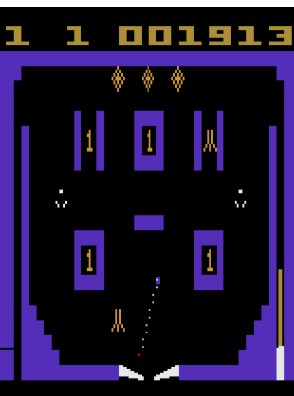
Figure 4. ATARI pinball game high scores, with double DQN [37].